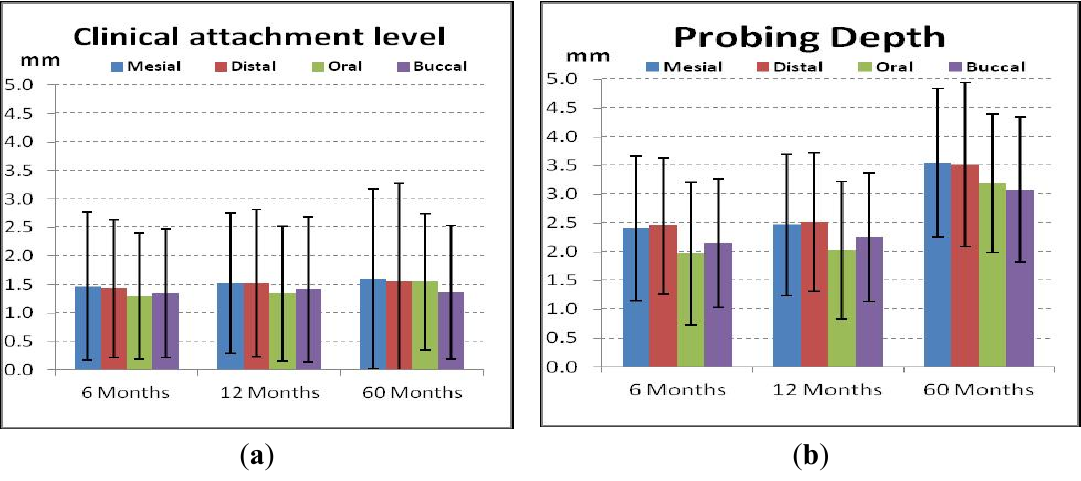
Figure 2. Peri-implant Parameters: CAL ( a ) and PD ( b ) as determined at four different sites around implants, 6 months, 12 months and 5 years post-loading.